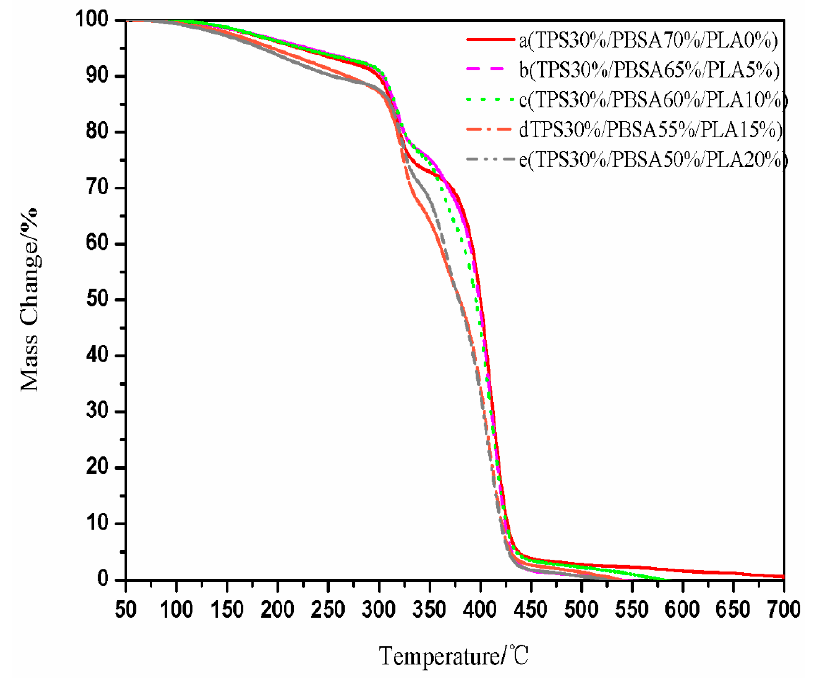
Figure 9. Thermal decomposition of the TPS/PBSA/PLA composites evaluated by